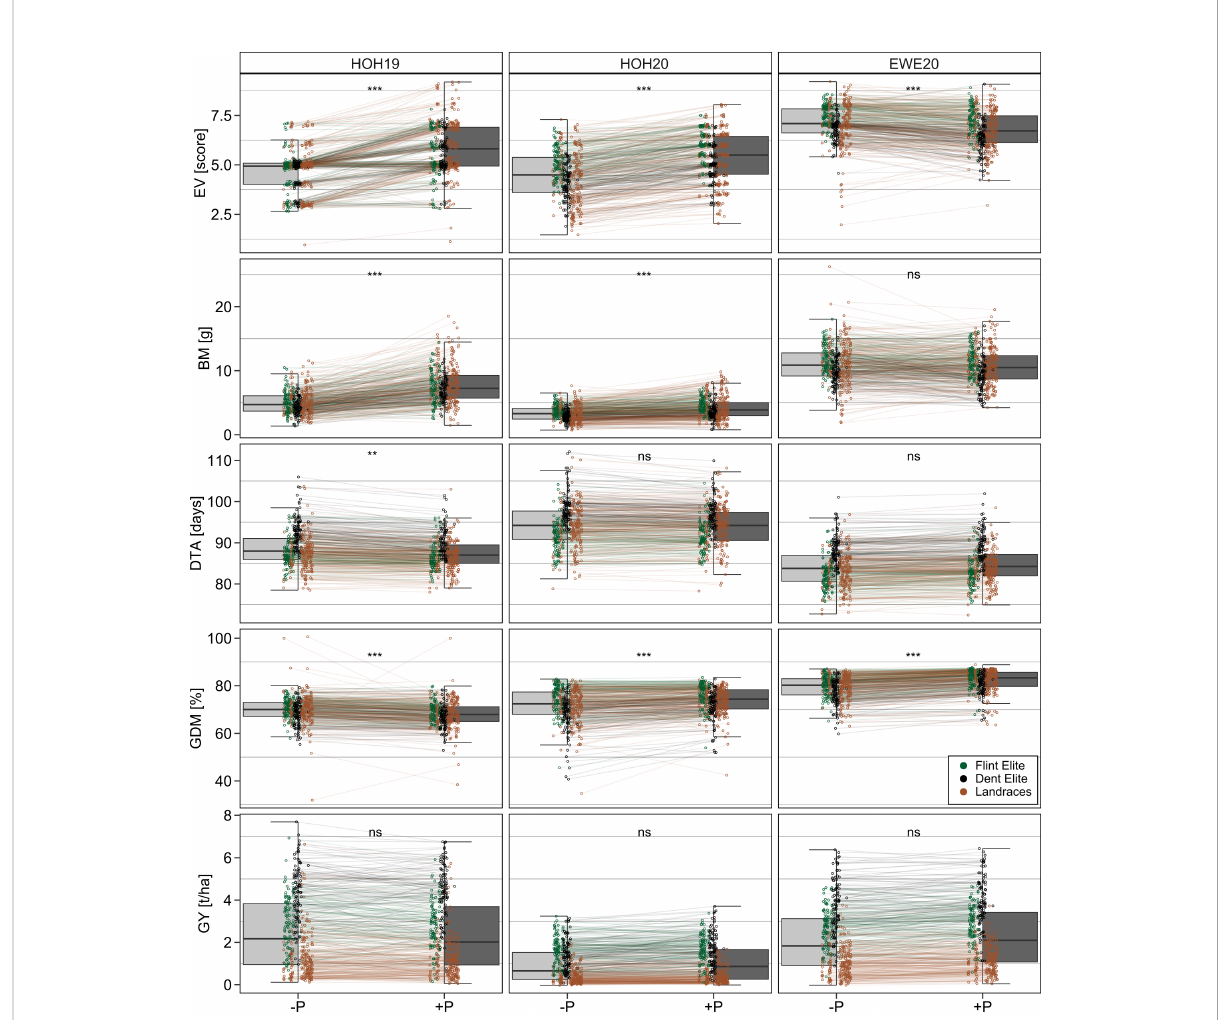
FIGURE 2 Trait differences between P treatments. Boxplots show trait distributions with (+P) or without (-P) starter fertilizer for each environment (HOH19, HOH20, EWE20). Note that genotypes in each treatment are connected by lines and colored as either Dent Elite, Flint Elite or landrace doubled haploid lines. Asterisks show signi fi cant differences between P treatment: ns, p > 0.05; *0.01 < p ≤ 0.05; **0.001 < p ≤ 0.01; ***p ≤